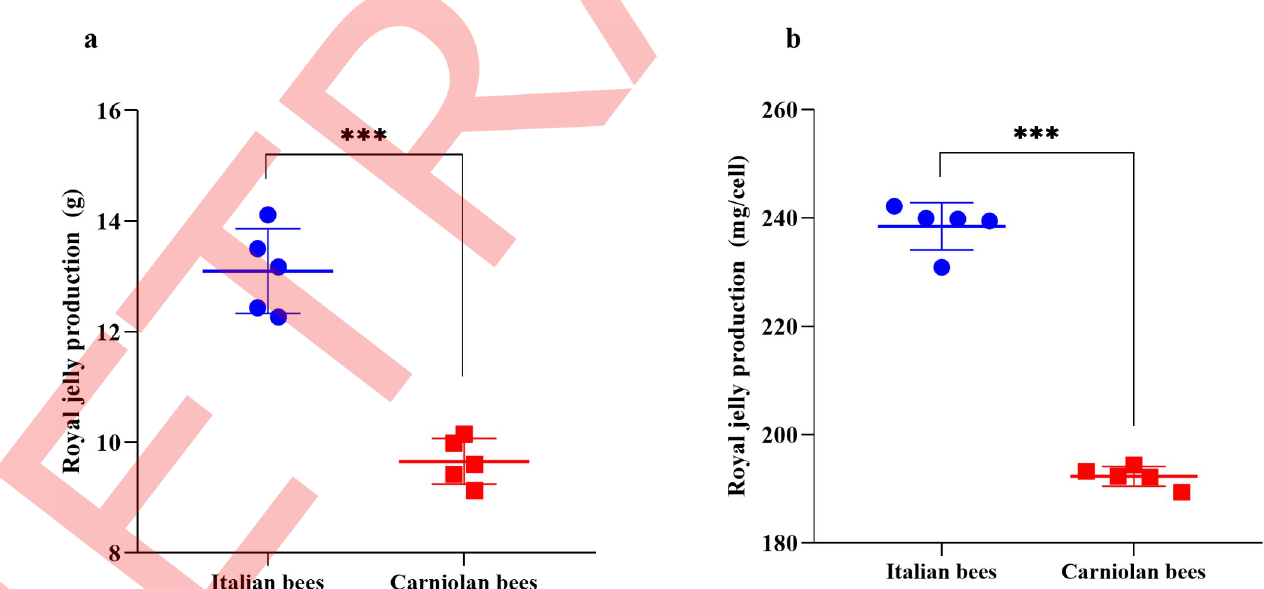
The effect of priming media on the queen cell acceptance rate and RJ production between Ital- ian and Carniolan bee races are shown in Fig 3.